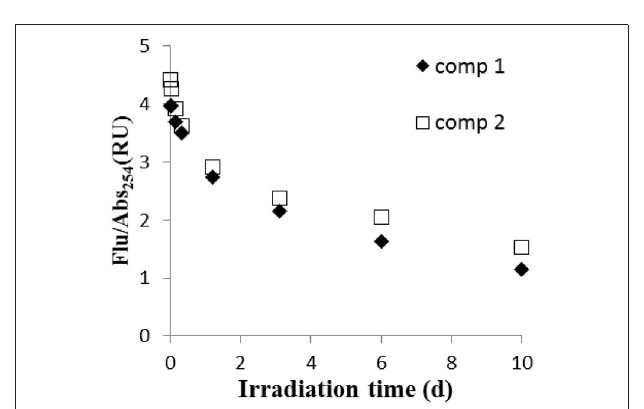
FIGURE 7 | The ratios of fluorescence (Flu) to absorbance at 254nm (Abs 254 ) for component 1 and 2.